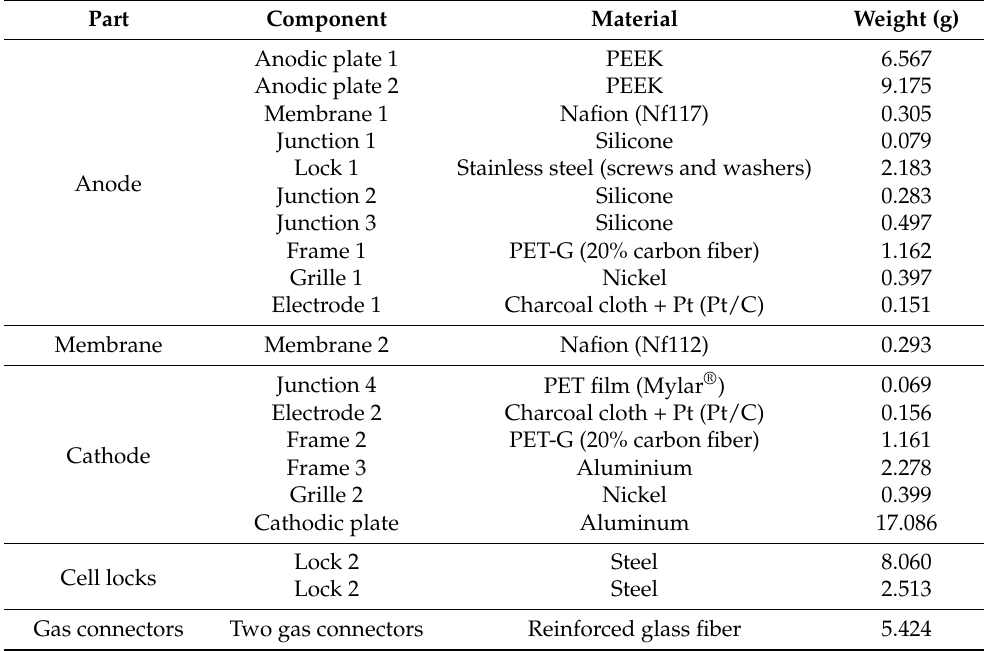
Table 1. LCI of the fuel cell